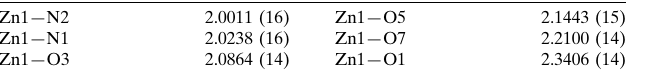
Selected bond lengths (A˚ ).